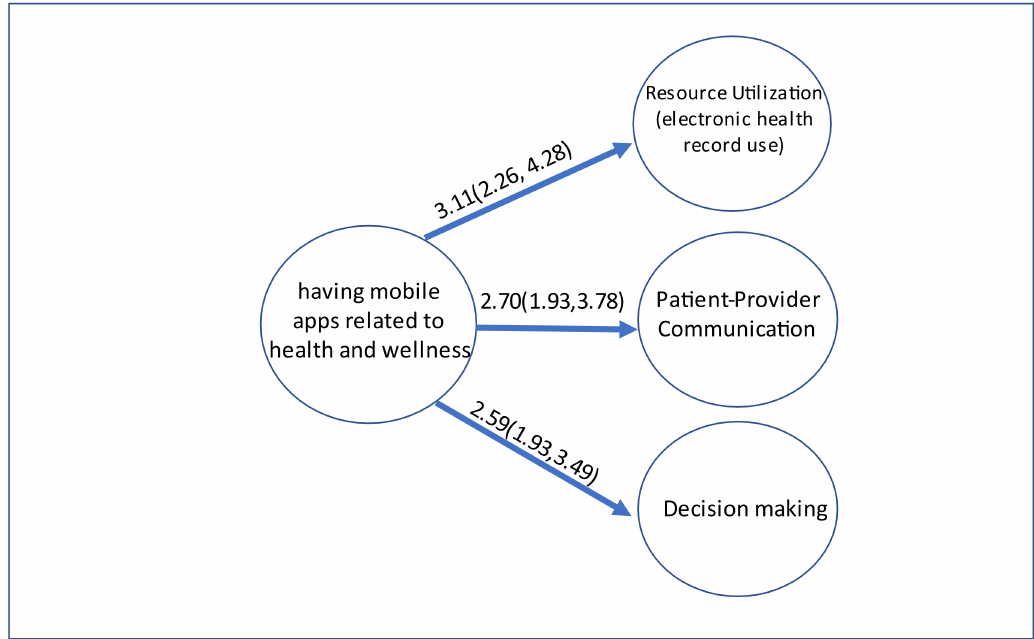
Figure 2. The Adjusted Odds Ratios and 95% Confidence Interval of mHealth Apps Associated with Three Different Management Behaviors Separately by using Multivariable Logistic